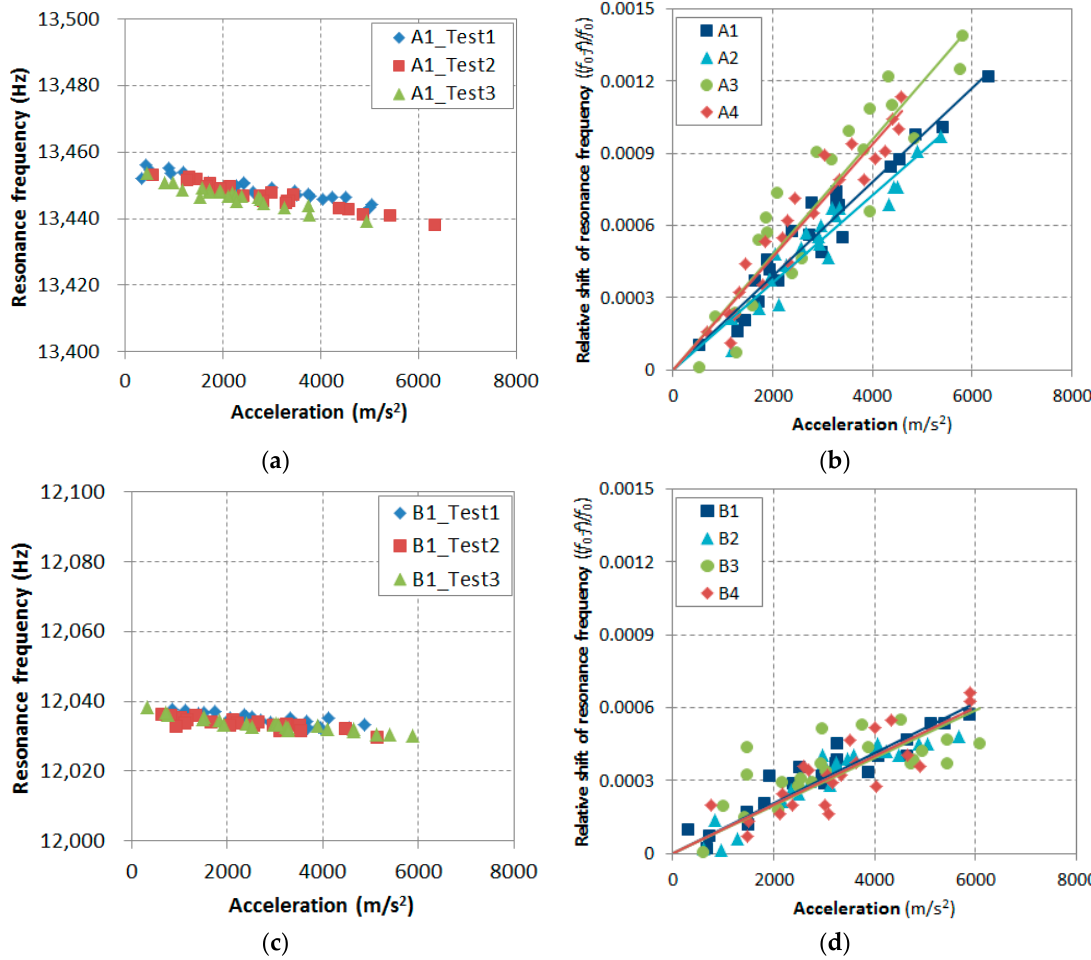
Figure 6. Repeatability and reproducibility test results at a higher acceleration.